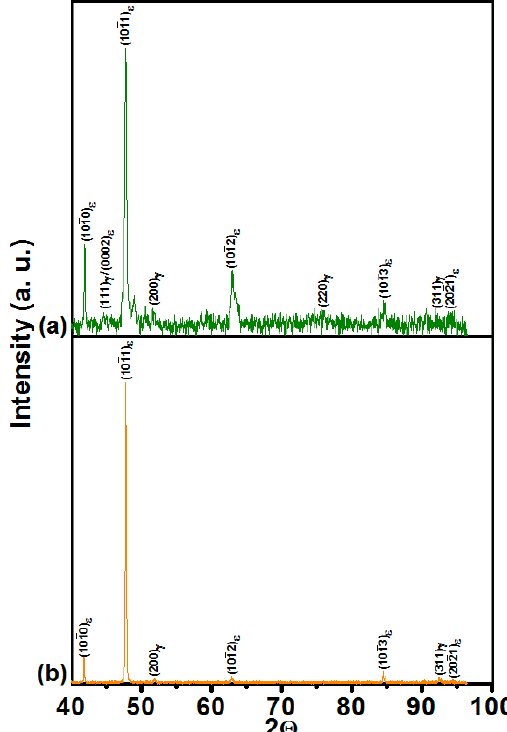
Figure 16. Diffraction patterns of Co ‐ 20 wt. % Cr alloy: ( a ) as ‐ chill cast condition; ( b ) heat ‐ treated condition.